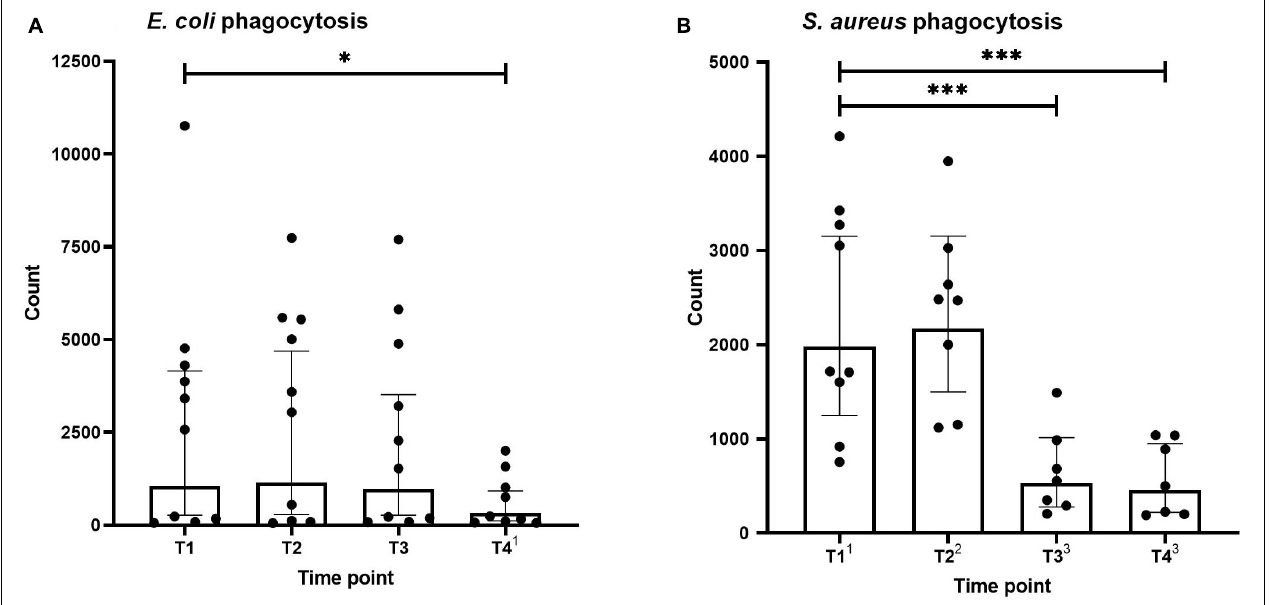
FIGURE 2 | Phagocytosis of Escherichia coli (A) and Staphylococcus aureus (B) by neutrophils. Data are represented as scatter plots with bars indicating geometric mean and whiskers representing 95% confidence interval (CI). Superscript font represents the number of missing values due to technical issues at each time point. ∗ p < 0.05 and ∗∗∗ p < 0.001 vs.